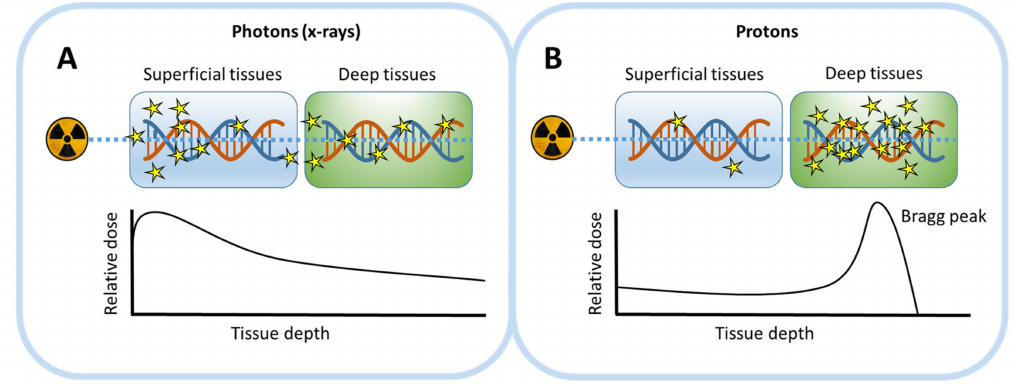
Figure 2. Overview of DNA damage induction patterns as a function of tissue depth for two types of EBRT, using either photon or proton beams. The induction of damage in superficial and deeper tissues is visualized (upper panel), as well as the course of the relative dose with increasing tissue depth (lower panel). ( A ) For photon beams, the highest dose will be deposited at the body entrance site, corresponding with the highest density of induced DNA lesions. The local relative dose will then decrease with increasing penetration depth in tissues. ( B ) For proton beams, the entrance dose is relatively low, followed by a sharp peak (the Bragg peak) in deeper tissues. Correspondingly, induced DNA damage will be most significant in these deeper